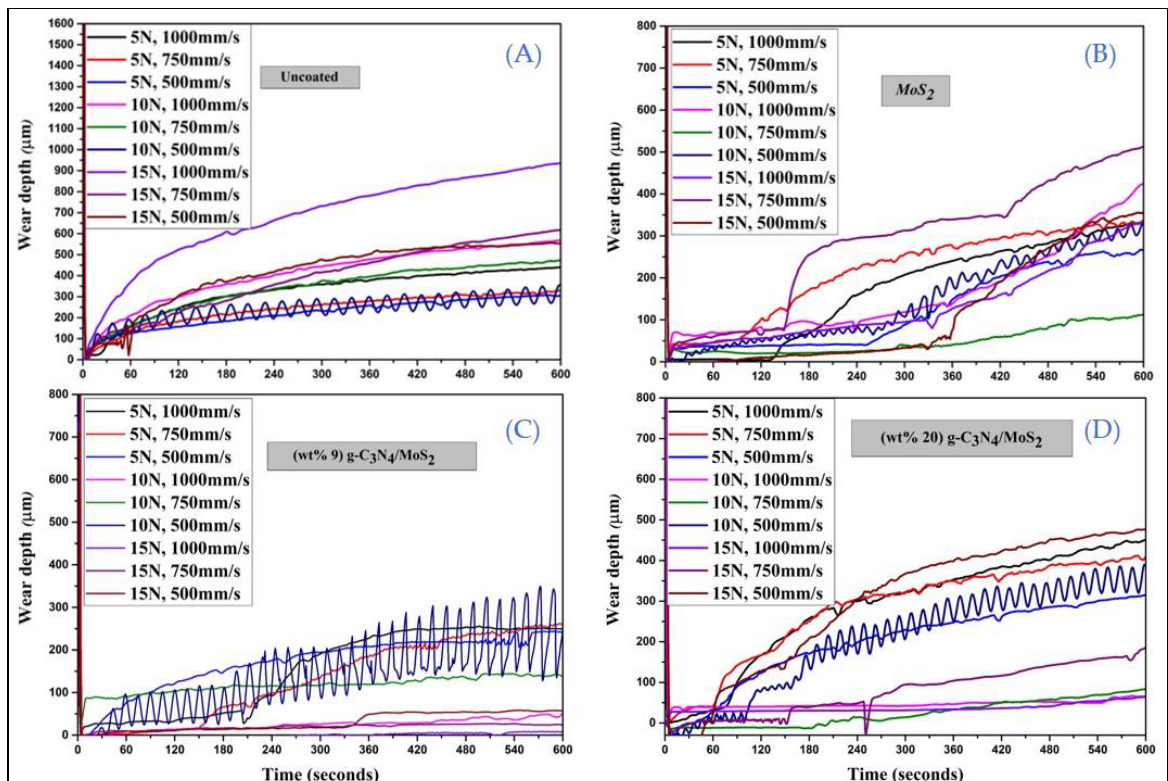
Figure 12. Wear depth vs. Time ( A ) for uncoated substrate; ( B ) for pure MoS 2 -coated substrate; ( C ) for 9 wt% g-C 3 N 4 /MoS 2 ( D ) 20 wt% g-C 3 N 4 /MoS 2 , at different sliding speeds and loadings.